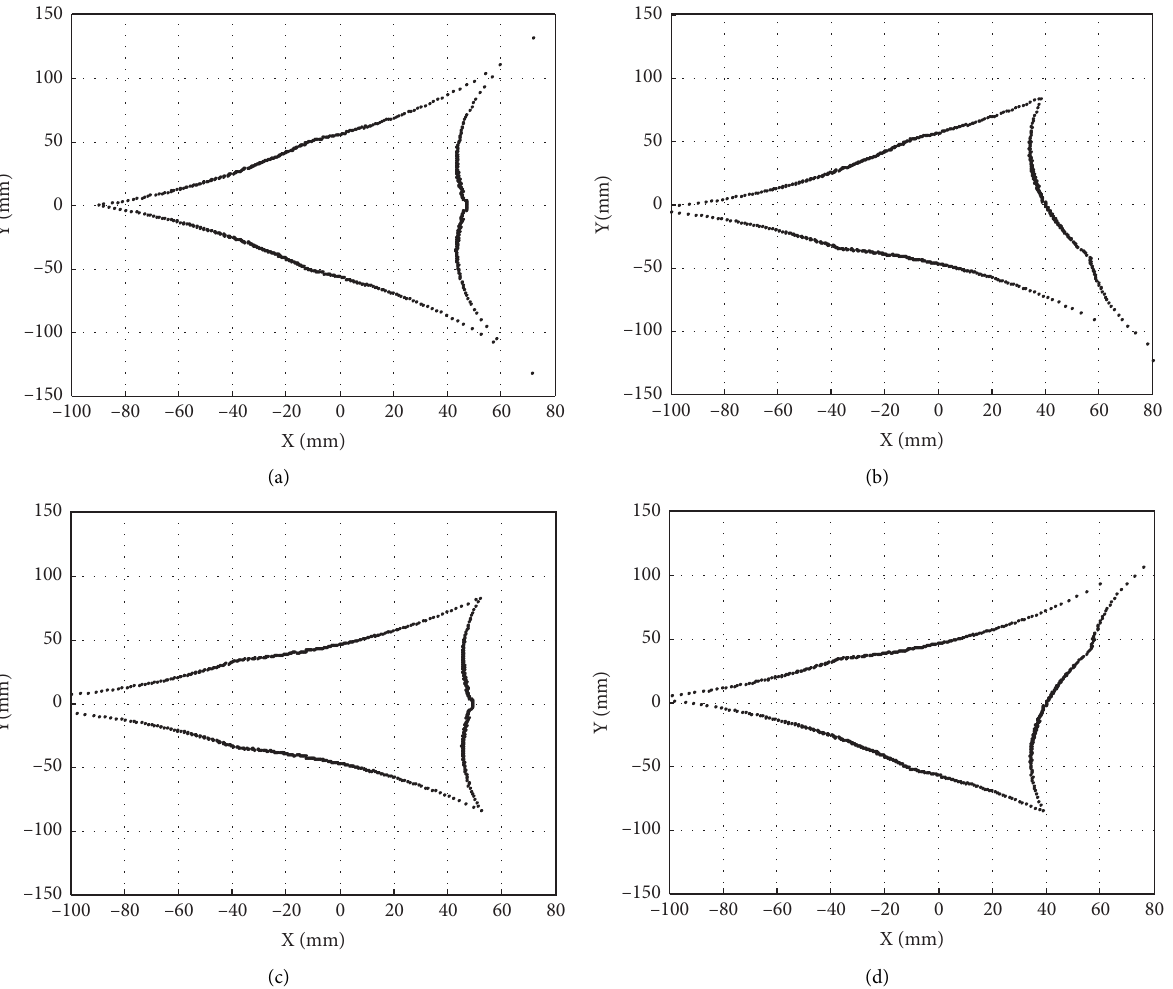
Figure 9: The boundary curves of position workspace. (a) ( α � c � 0, β � 2.52 ° , ( Z ) �− 45). (b) ( α � 2.52 ° , β � 0, c � − 4.47 ° , ( Z ) �− 45). (c) ( α � c � 0, β �− 2.52 ° , ( Z ) � − 45). (d) ( α � − 2.52 ° , β � 0, c � 4.47 ° , ( Z ) �−